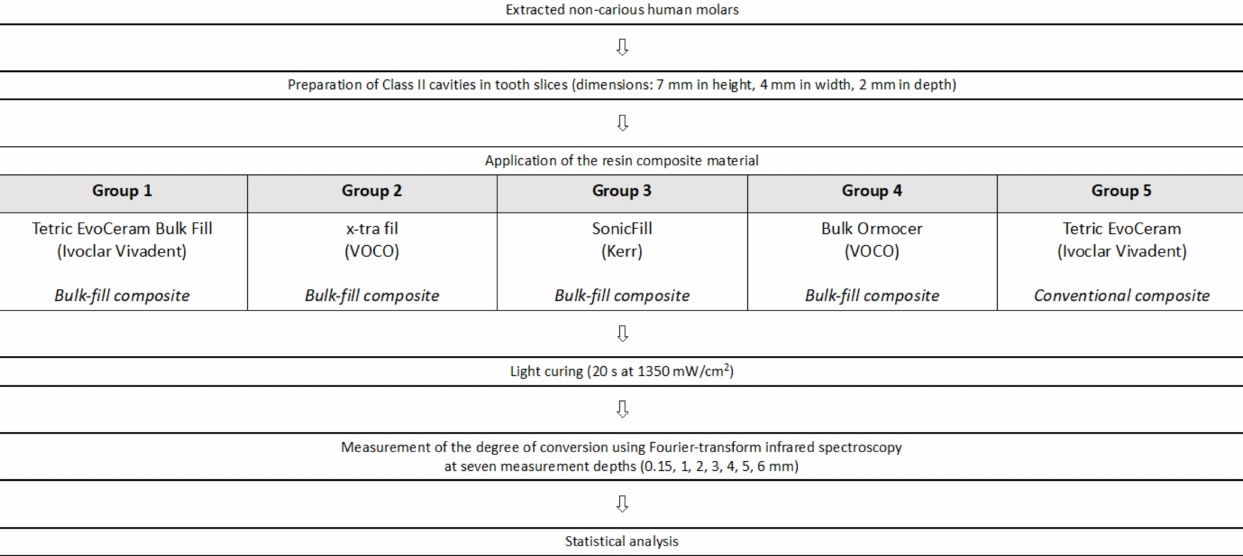
Figure 2. Experimental